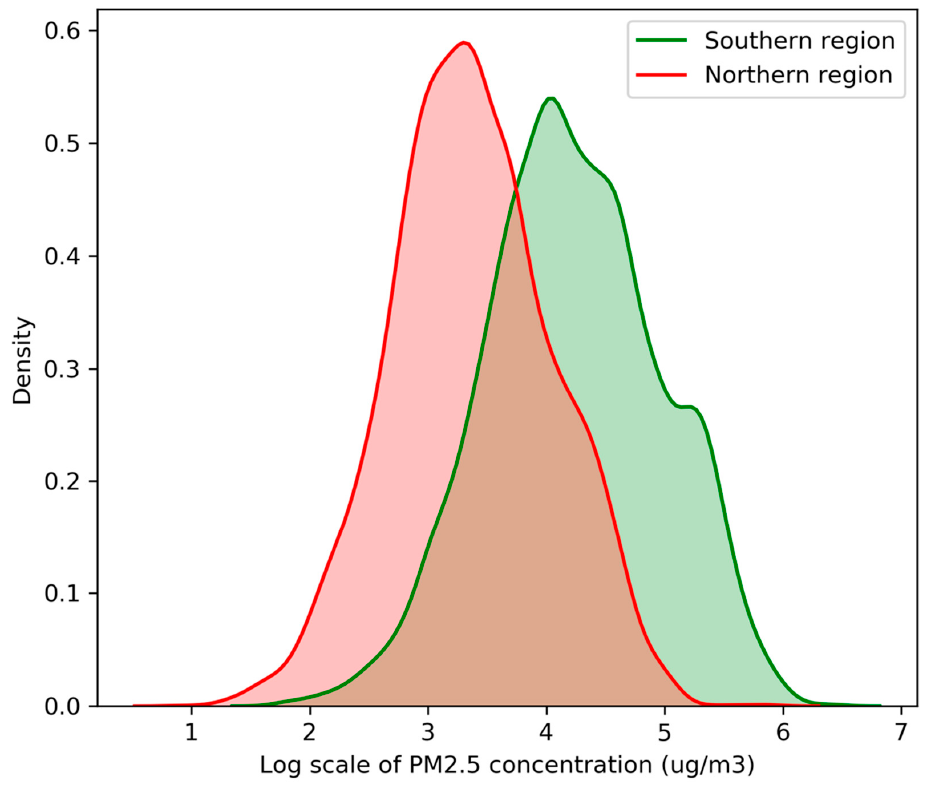
Figure 5. Density of PM 2.5 concentration in southern and northern region.